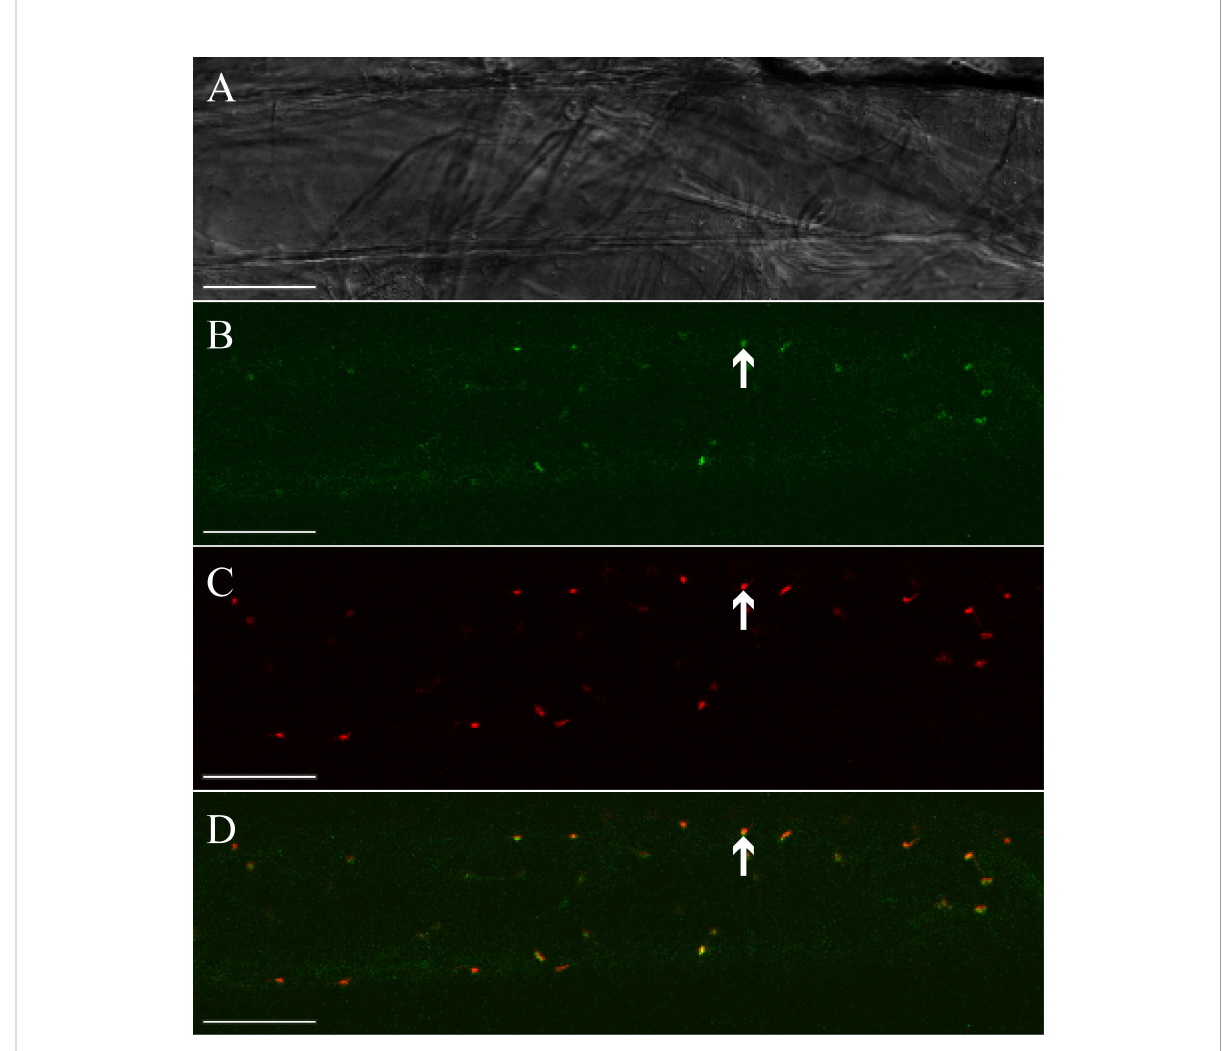
FIGURE 2 Subcellular localization of LiLOX yellow fl uorescence fusion protein (LiLOX-eYFP). Confocal microscopy of epithelial onion cell co-transformed with LiLOX-eYFP and acyl carrier protein fused to cyan fl uorescence protein (ACP-eCFP). (A) Bright fi eld. (B) LiLOX-eYFP. (C) ACP-CFP. (D) Merged signals of LiLOX-eYFP and ACP-eCFP. All 10 cells analyzed from a single experiment showed comparable results. White Bar: 100 m